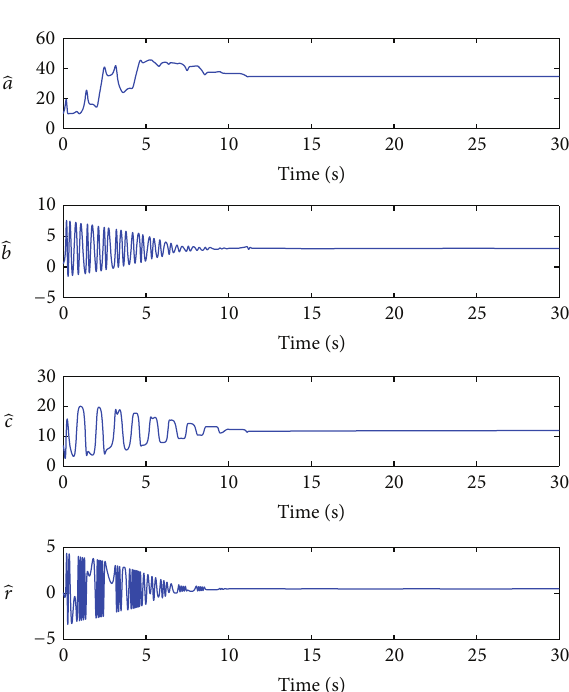
Figure 5: The estimated values of the unknown parameters 𝑎 1 , 𝑏 1 , 𝑟 𝑐 1 , and 1 .